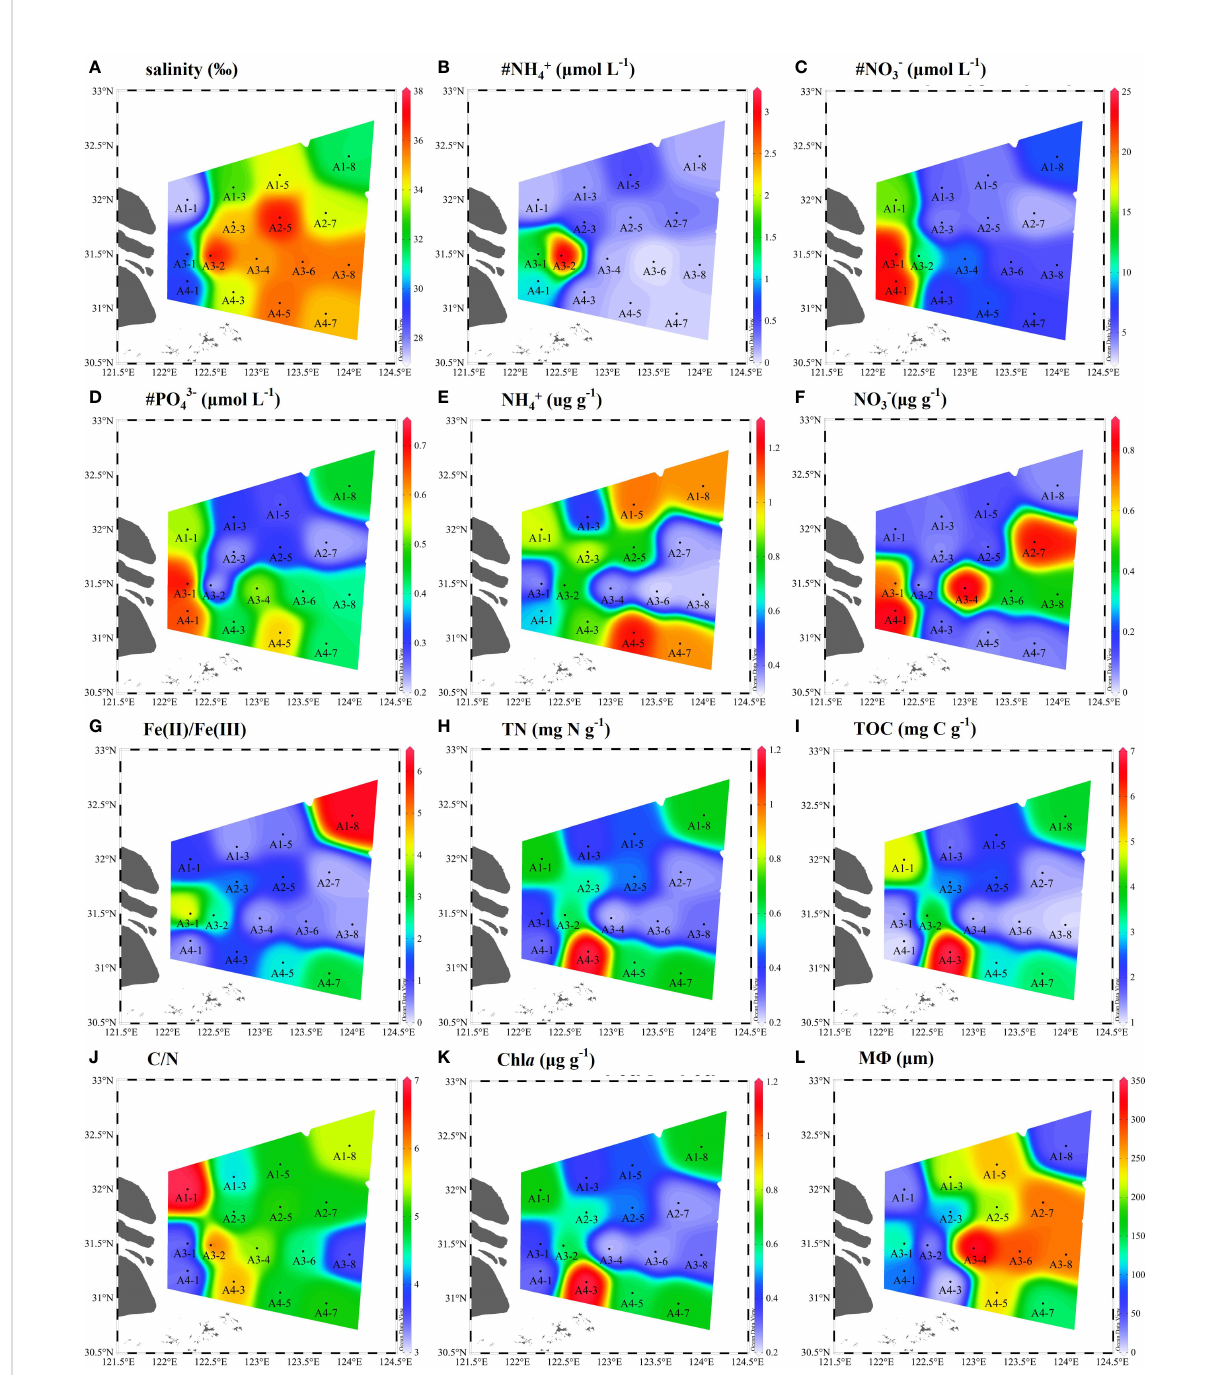
FIGURE 2 Spatial distributions of physicochemical parameters in bottom water and surface sediments of the Yangtze Estuary and East China Sea (ECS) (A- L) . # represents the bottom water properties (# NH 4+ , # NO